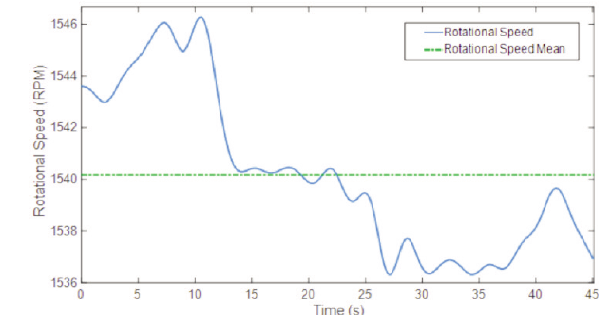
The speed variation when the drill approaches the bone Fig. 4: and passes through the proximal cortex – medulla – distal cortex (Drill 2).